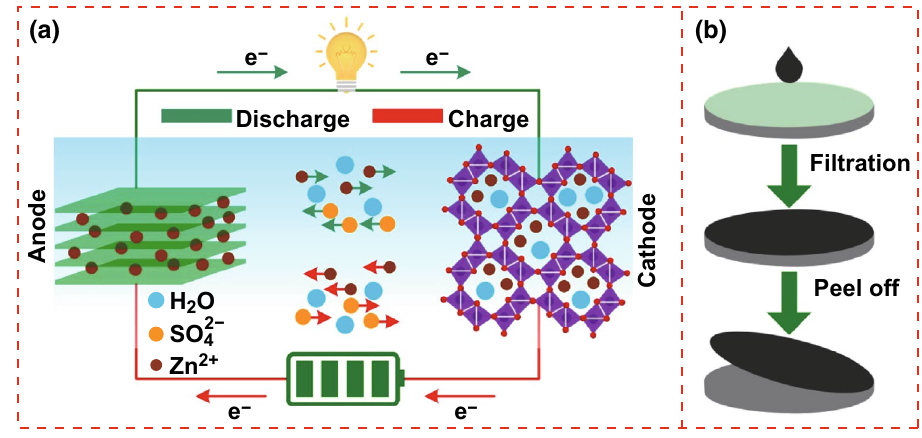
Fig. 1 Schematic diagram of the ZIC and fabrication procedure of the free‑standing electrodes, a schematic diagram of the ZIC: MnO 2 –CNTs serve as the cathode, MXene serves as the anode, and 2 M ZnSO 4 and 0.1 M MnSO 4 serve as the electrolyte; b fabrication procedure of the free‑ standing MnO 2 –CNTs cathode and MXene